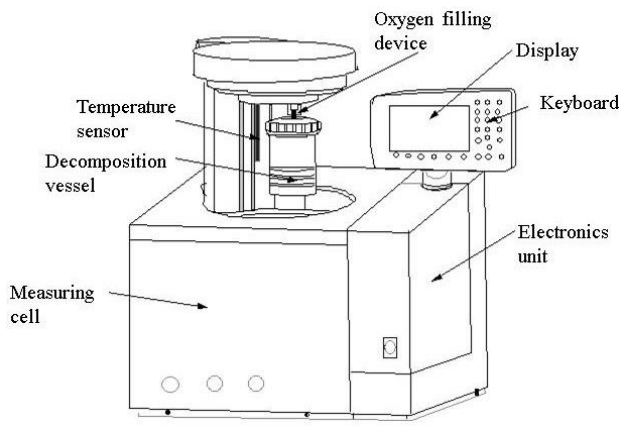
Figure 5. Schematic diagram of the bomb-type calorimeter.